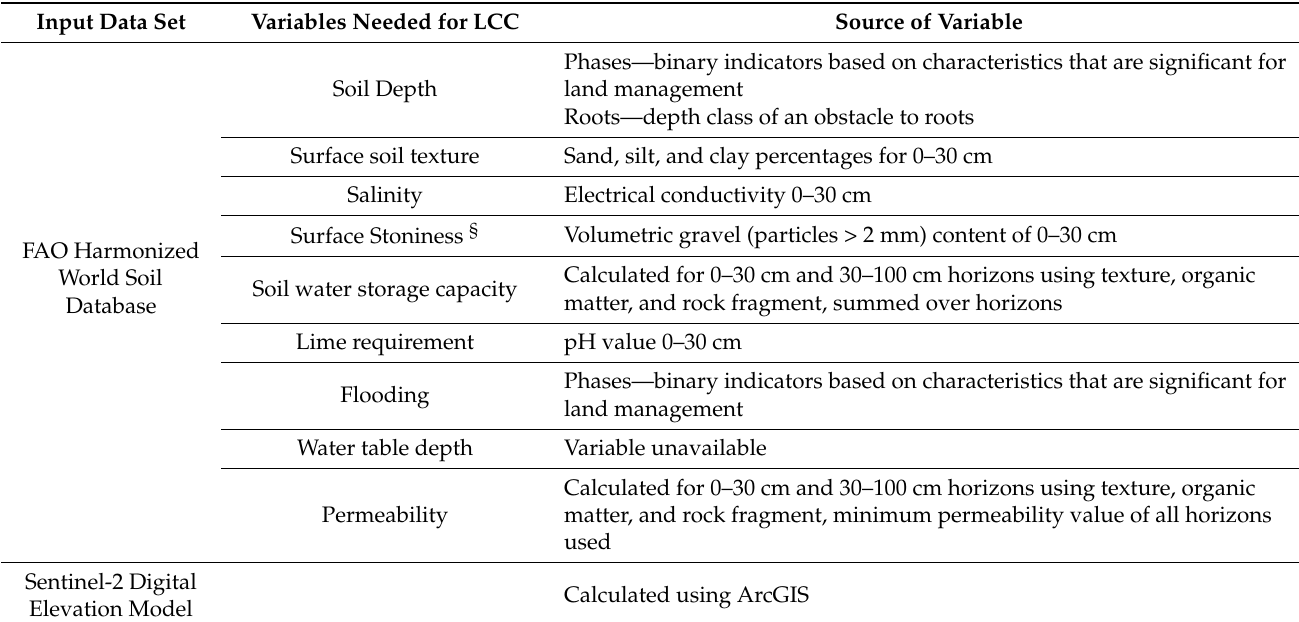
Table 5. LCC Calibrations—Digital Soil Data Source